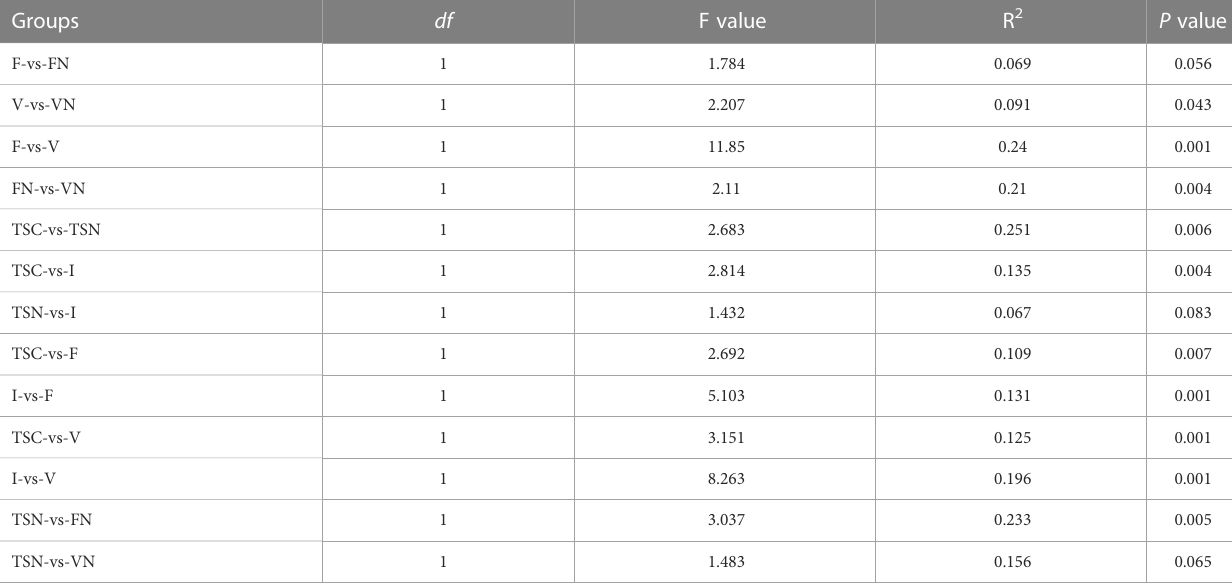
TABLE 2 Statistical analyses of